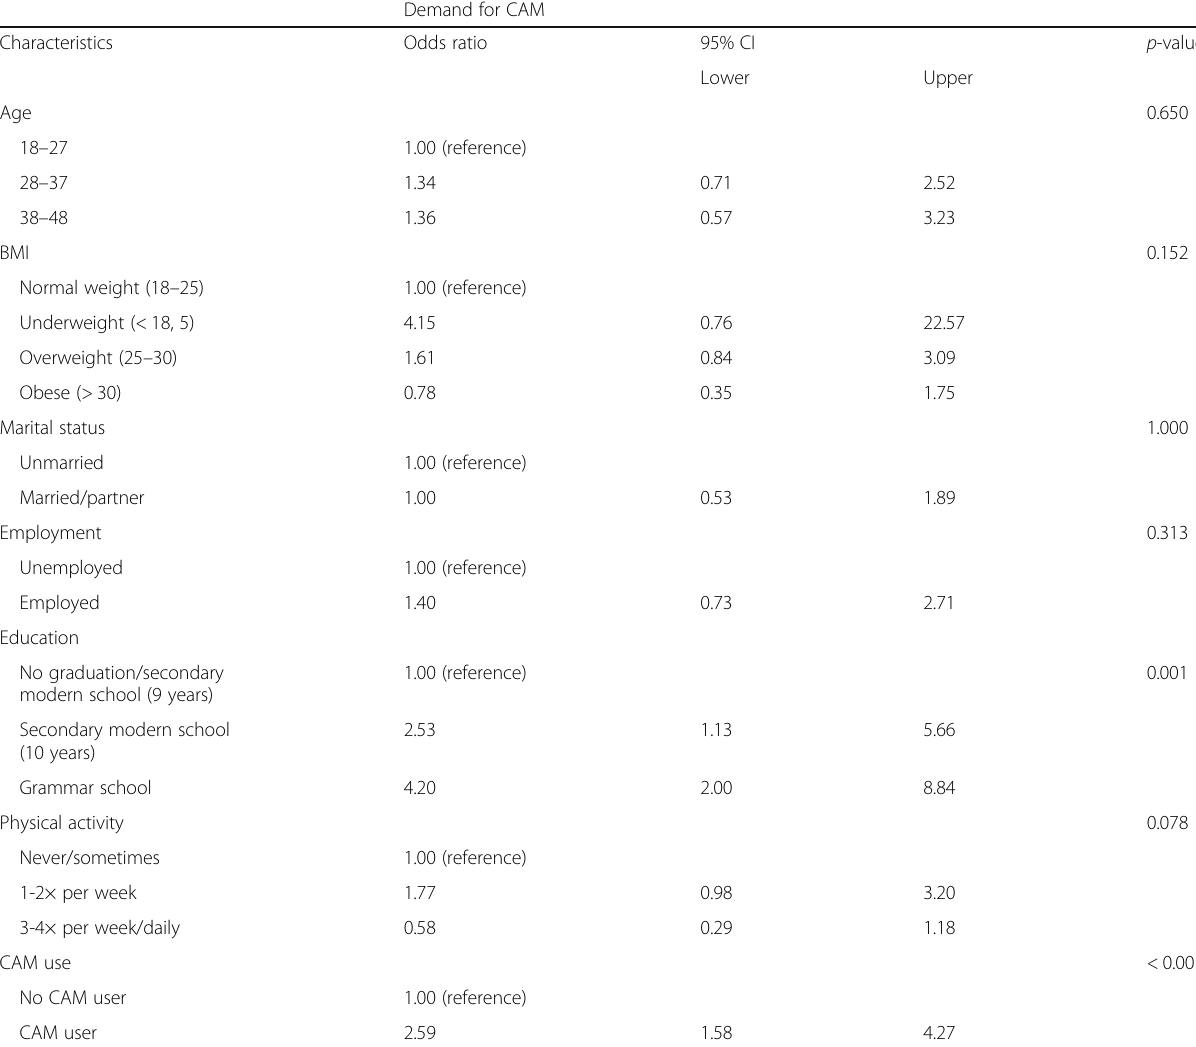
Table 4 Bivariate logistic regression model with odds ratio of demand for CAM, adjusted for participants ’ characteristics Demand for